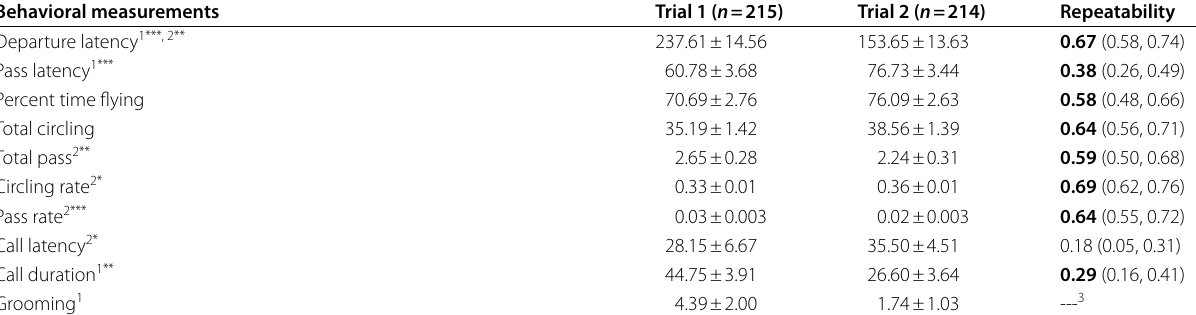
Table 3 Mean (± SE ) behavioral performances and behavioral repeatability (assessed by R value with 95% CI in parenthesis) of eastern bent-wing bats in flight-tent